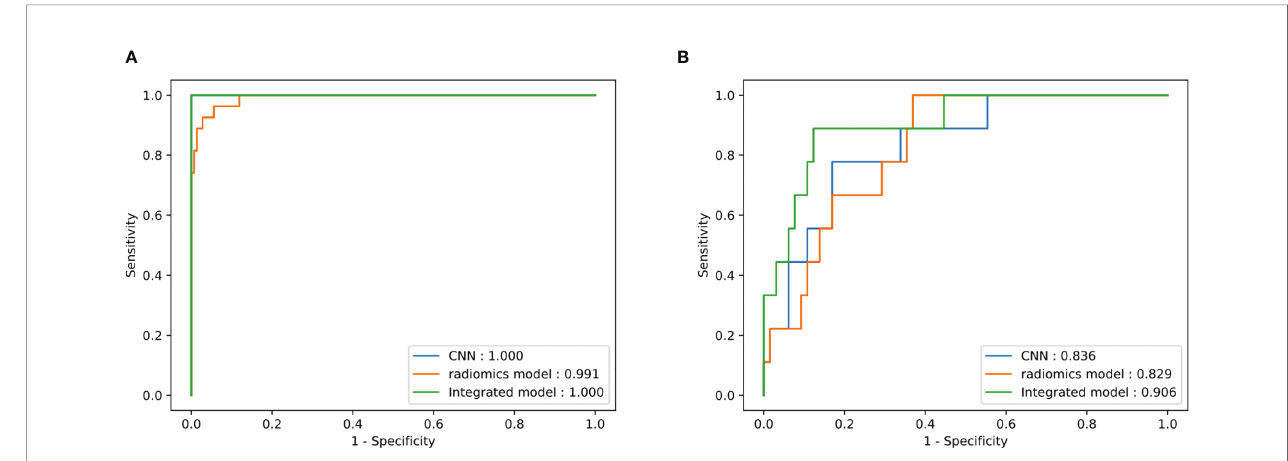
FIGURE 4 | Receiver operating characteristic (ROC) curve of the three models in the training (A) and test (B)